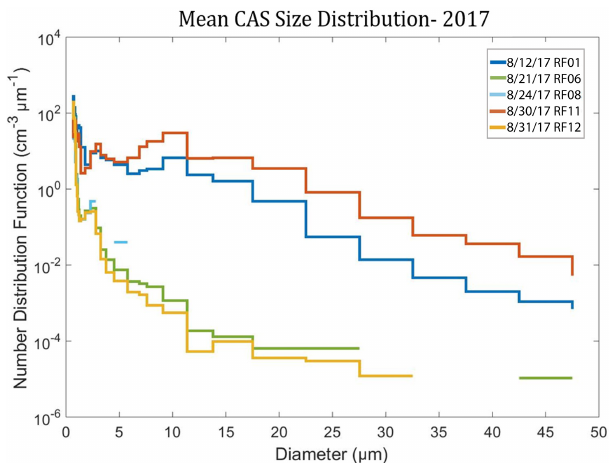
Figure 5. Mean cloud and aerosol spectrometer (CAS) aerosol size distribution for five research flights during a 5min interval when 2D-S SAPs were measured within the BB